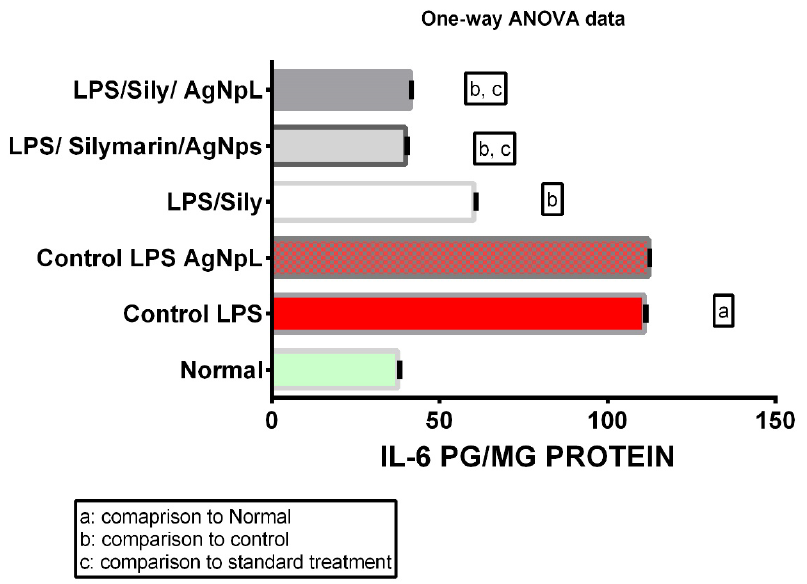
Figure 6. Expression levels of IL-6 among different groups.